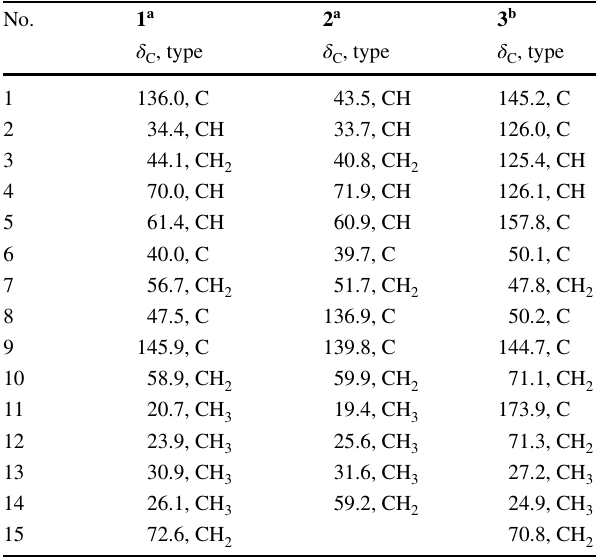
Table 2 13 C NMR data ( δ in ppm) of compounds 1 – 3